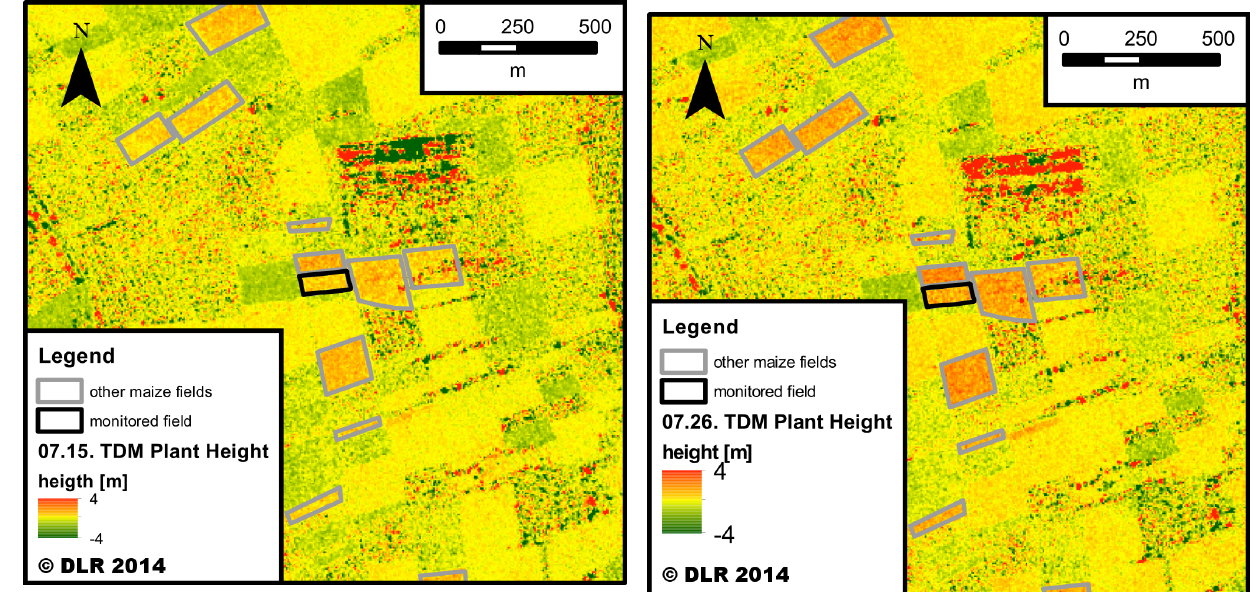
Figure 6. Heigth difference between June 1st and July 15th, de- rived from TDM.